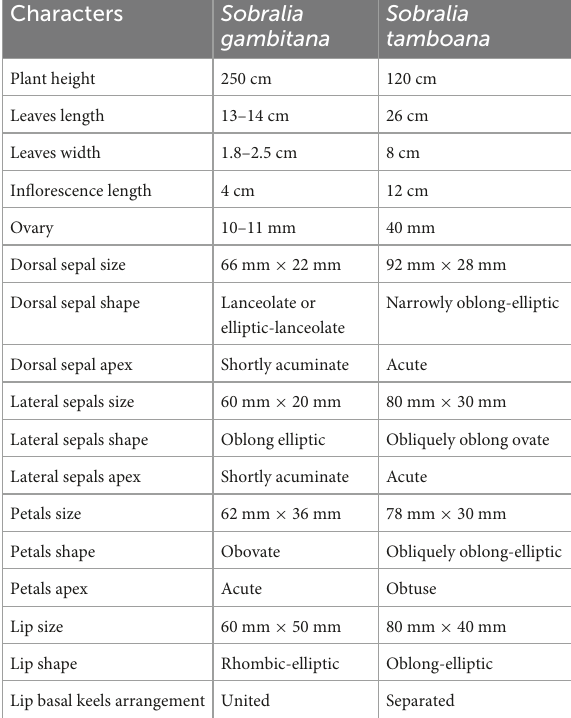
TABLE 1 Comparison of Sobralia gambitana Baranow, Szlach. and Kindlmann and S. tamboana